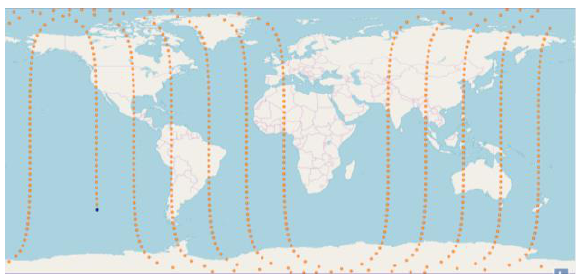
Figure 4: Results of simulated space debris tracking. In this, Iridium 33 DEB is considered as a dysfunctional space object after its collision with Cosmos 2251 in 2009 (NASA Orbital Debris Program Office, 2009).